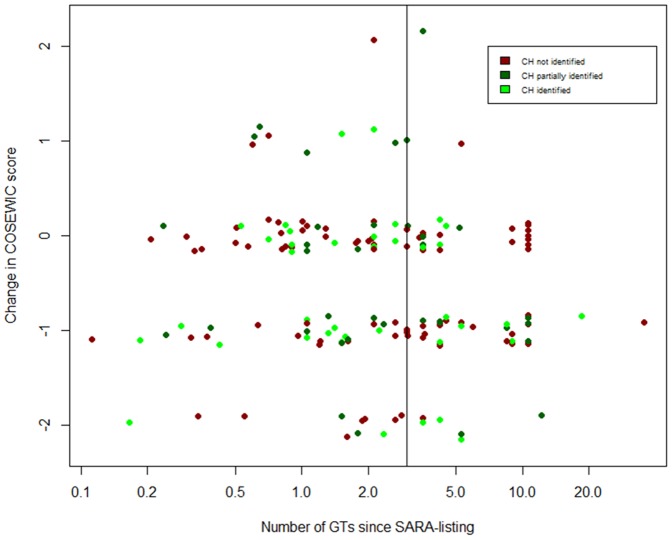
Change in COSEWIC assessment statuses versus the number of GT that have passed since initial SARA listing for all schedule 1 species listed as threatened, endangered, or extirpated.Dot colour indicates whether CH has been fully identified (green), partially identified (dark green), or not identified (red). The black vertical line indicates three GT.